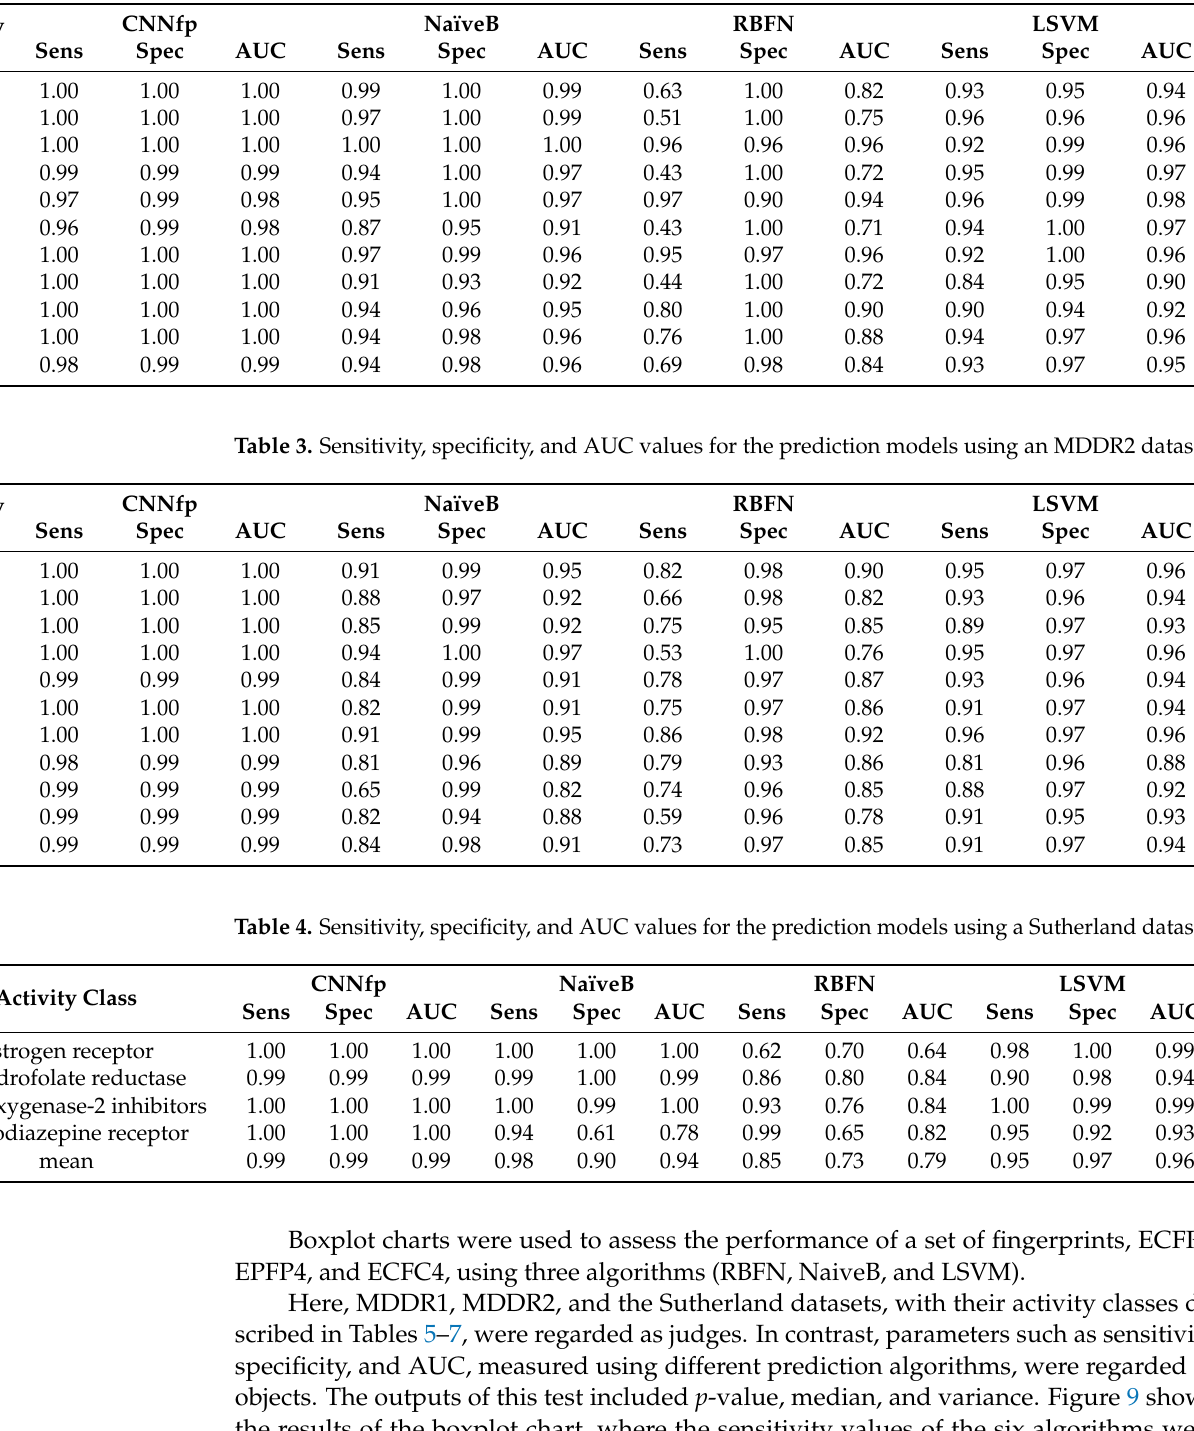
Table 2. Sensitivity, specificity, and AUC values for all the prediction models using an MDDR1 dataset.